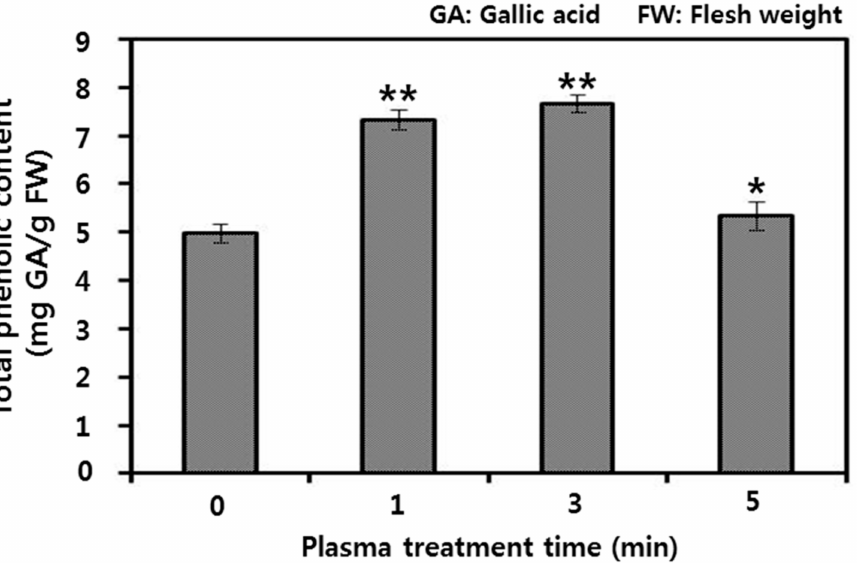
Figure 4. Total antioxidant capacity in rice stem cell extracts (RSCE) according to the plasma treatment time. All measurements were made in 3 or more than 3 replicates. * p < 0.05; ** p <